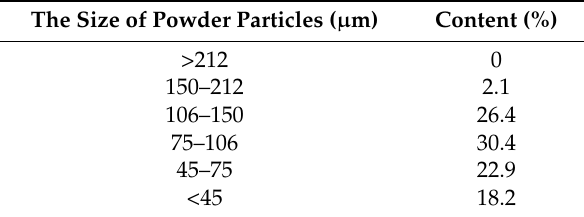
Table 1. The sieve analysis of PNC-60 powder.